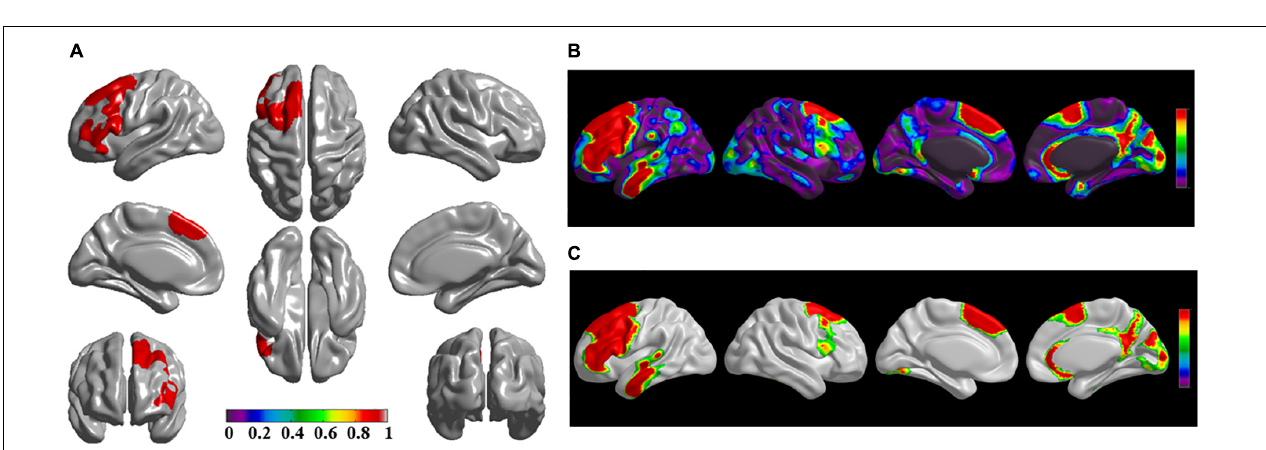
FIGURE 3 | The significantly altered brain regions of cortical structural connectivity in the sPD brain based on seed 3. (A) The brain regions of seed 3, the red brain regions represent the cortical thickness thinning regions. (B) The significantly altered brain regions in the F-map based on seed 3, the red, and green brain regions represent the brain regions of significant cortical structural connectivity alteration that were not corrected by the FWE. (C) The significantly altered brain regions after FWE correction based on seed 3, the red and green brain regions represent the brain regions of significant cortical structural connectivity alteration that were corrected by the FWE.